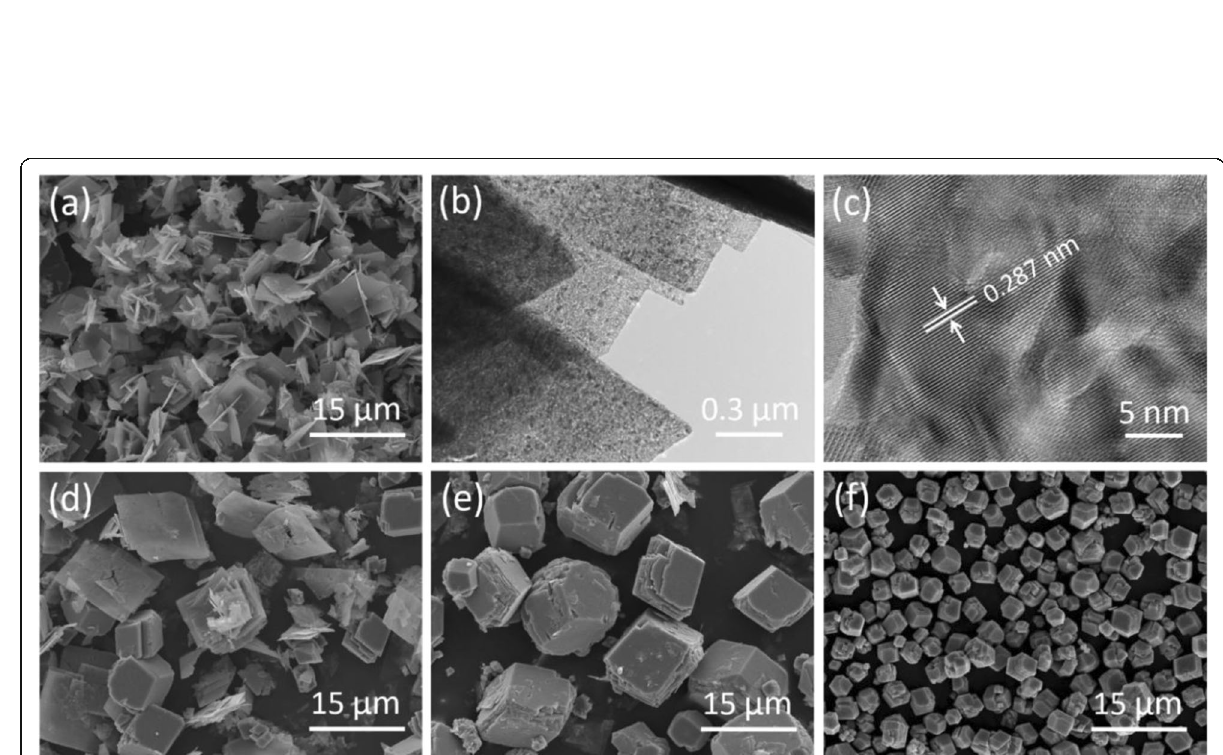
Fig. 2 a Raman spectrum and b XPS survey spectrum of porous Co 3 O 4 cubes, and the core-level spectra for c Co 2p and d O